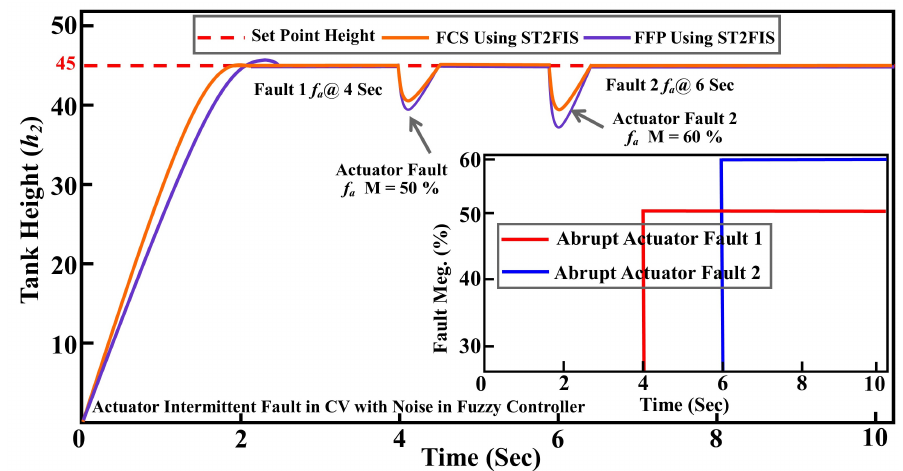
Figure 16. Comparative results of TTCFNLC process subject to random noise in the fuzzy controller and actuator fault in TTCFNLC process using fuzzy CS and FP algorithms.